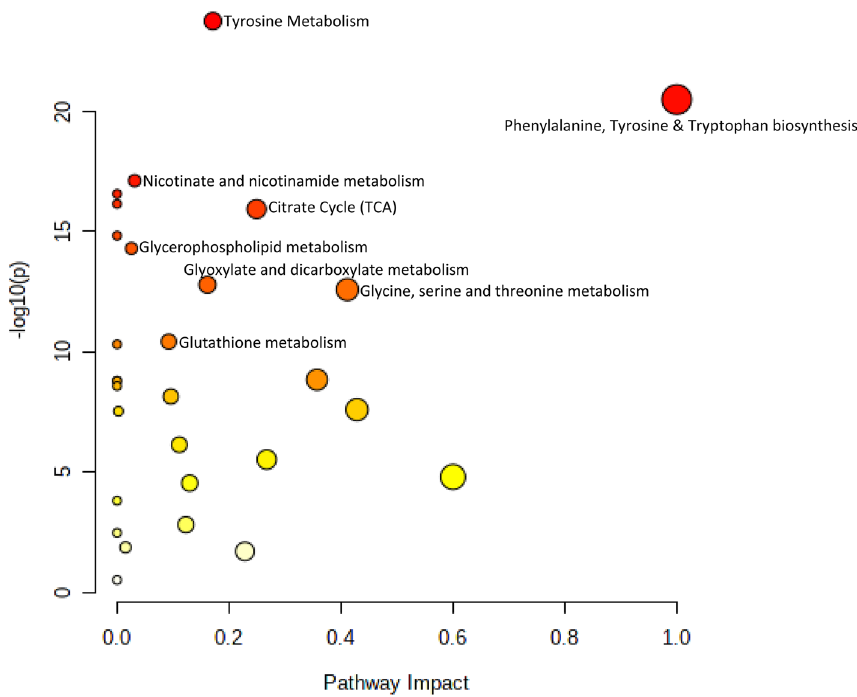
Figure 10. Summary of altered metabolic pathways in response to high altitude hypoxia